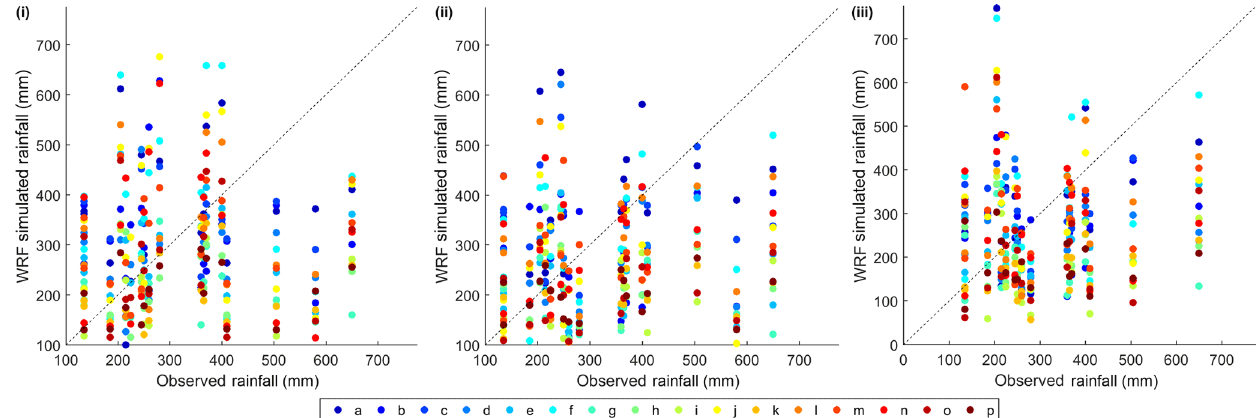
Figure 6. Scatter plots between the rainfall data from the rain gauges and the WRF simulations for (i) Domain 1, (ii) Domain 2a and (iii) Do- main 2b for WRF configurations (a) to (p). Refer to Appendix A (Table A1) for the detailed list of the WRF configurations.